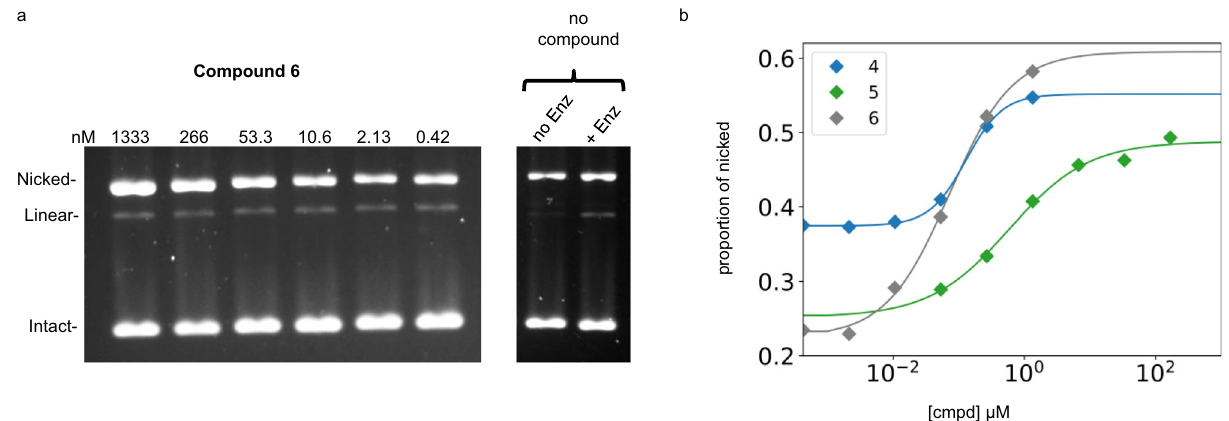
Fig. 3 Cleavage assay with E. coli DNA gyrase. Cleavage complexes formed by 4 – 6 were trapped with SDS (see “ Methods ” ) before treatment with Proteinase K. The cleaved plasmids were resolved by agarose gel electrophoresis. a Gel image for 6 ; increasing amount of compound results in increasing nicked DNA being trapped. No increase in linear plasmid was observed. b The gel for compound 6 and similar gels for 4 and 5 (Supplementary Fig. 8) were quanti fi ed by densitometry. The proportion of nicked to the total amount of DNA in the lane was plotted against the compound concentration in b . For each compound, the data were fi tted to the Hill equation. The EC 50 parameter for the best fi t is the measured CC 50 . The cleavage assays were reproduced three times, while the no enzyme control was reproduced twice with similar results. Uncropped versions of gel images are available as Supplementary Figs. 22 and